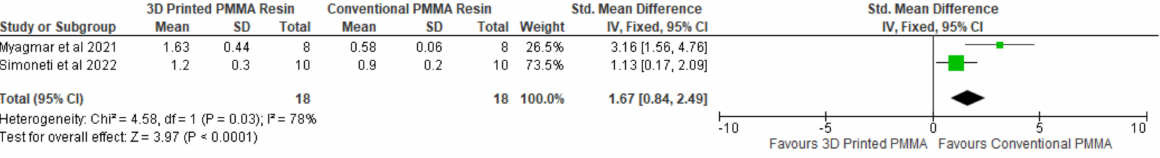
Figure 8. Forest plot comparing surface roughness between 3D-printed PMMA resin and conventional PMMA resin.